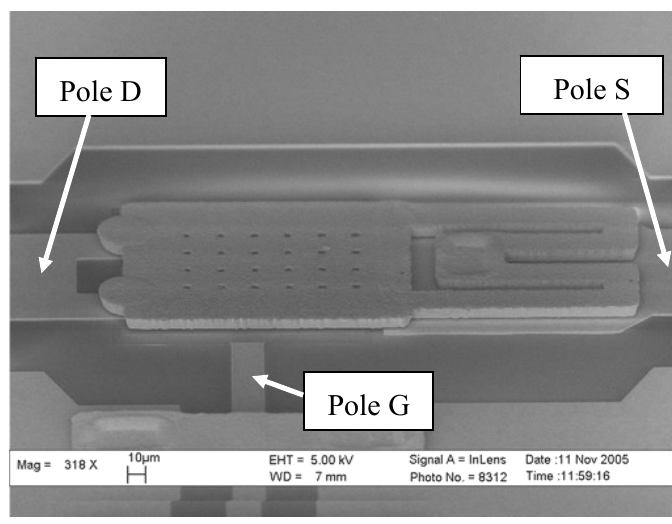
Figure 1. SEM image of 3-port ohmic MEMS switch.